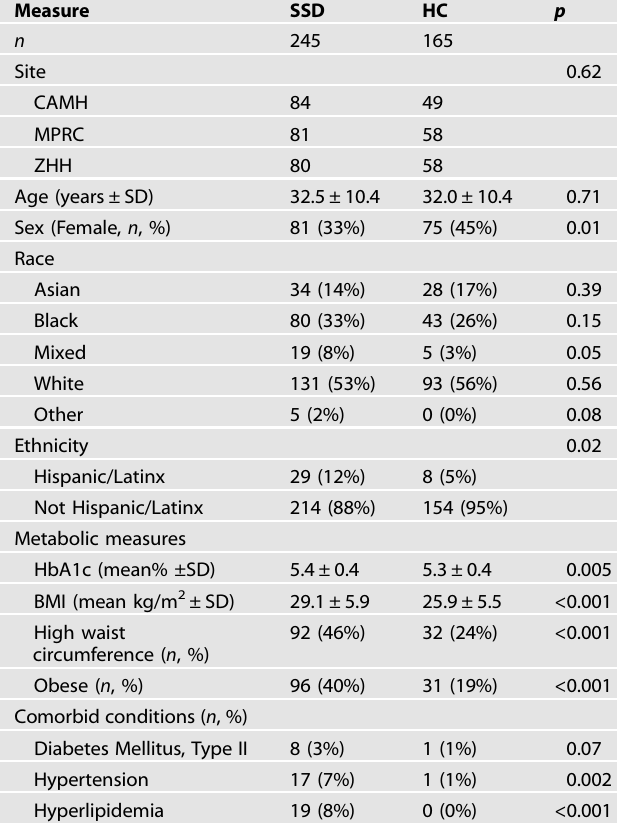
Table 1. Participant